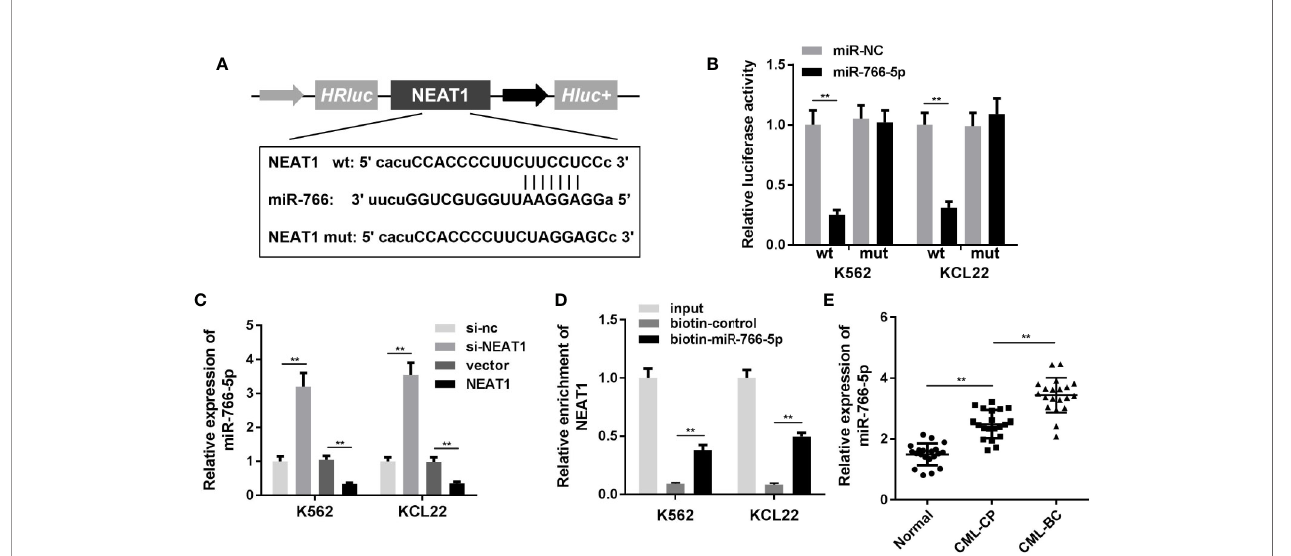
FIGURE 3 | NEAT1 sponges miR-766-5p. (A) The binding sites between miR-766-5p NEAT1. (B) The luciferase activity of CML cells. (C) The expression of miR-766-5p in CML cells. (D) The interaction between NEAT1 and miR-766-5p. (E) The expression of miR-766-5p in CML patients. **P < 0.01 vs. miR-NC, si-NC, vector, biotin-NC or normal. CML, chronic myeloid leukemia; NEAT1, lncRNA nuclear enriched abundant transcript 1; CP, chronic phase; BC, blast crisis; NC, negative control.